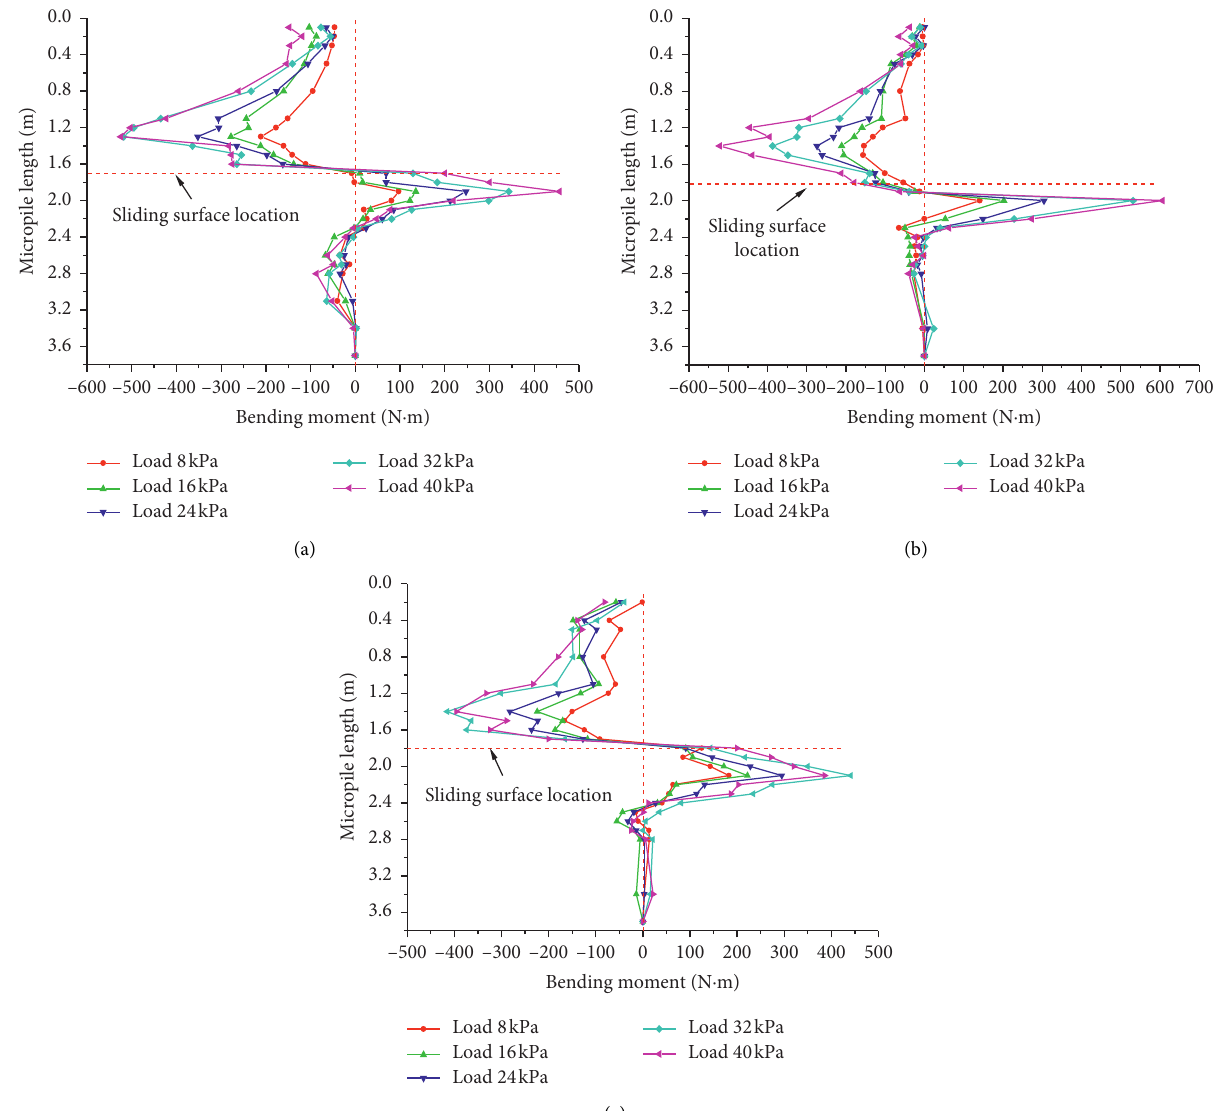
Figure 13: Bending moment of micropiles. (a) Bending moment of the pile in first row; (b) bending moment of the pile in middle row; (c) bending moment of the pile in last